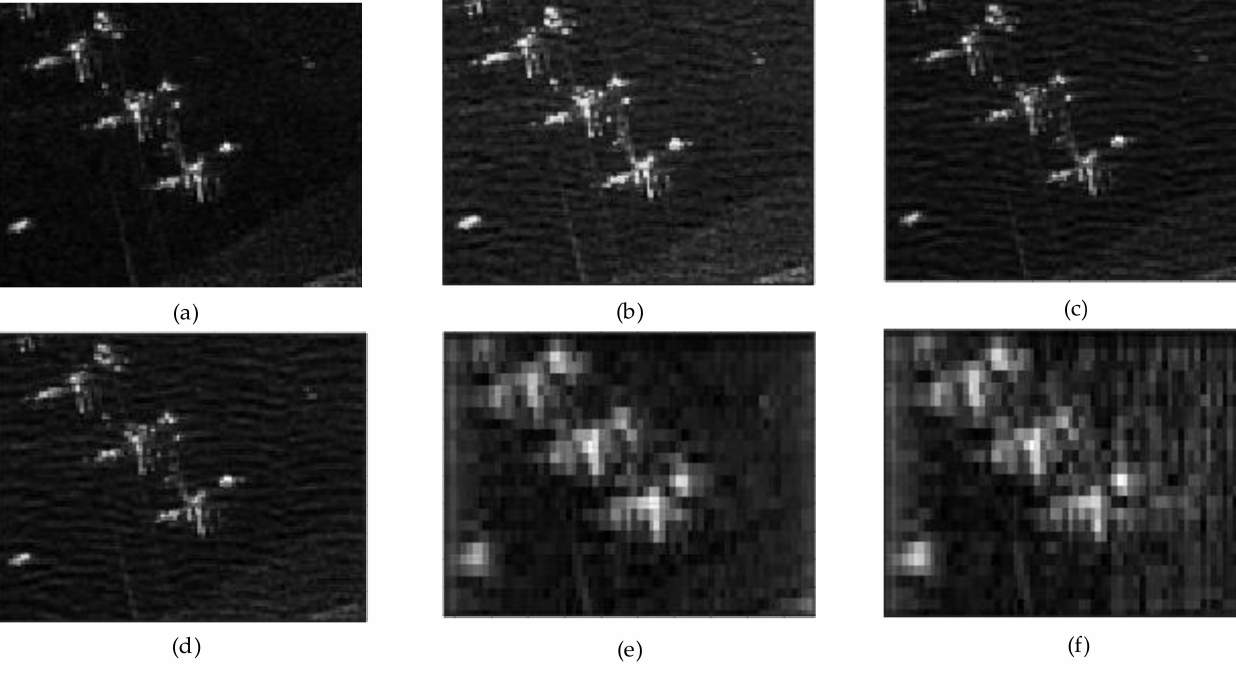
Figure 9. Plane target imaging results. ( a ) is original plane target, ( b ) is our proposed method with L = 3, ( c ) is our proposed method with L = 8, ( d ) is our proposed method with L = 11, ( e ) is ISTA method and ( f ) is Fast ISTA